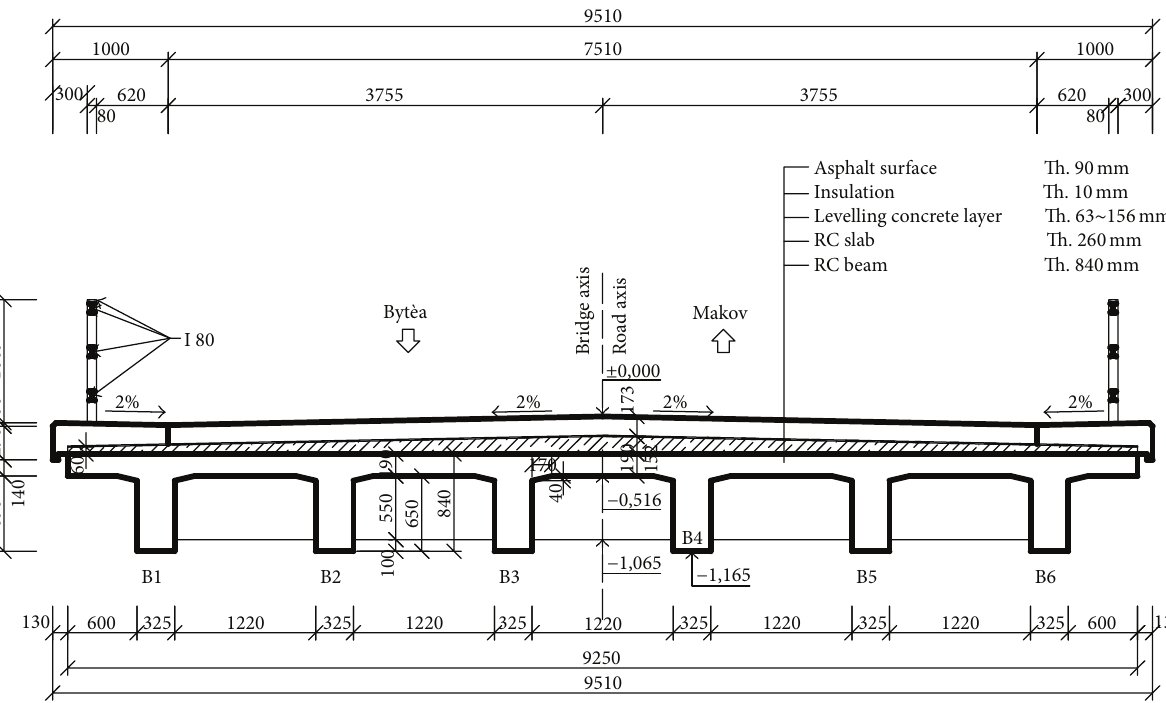
Figure 2: The bridge cross